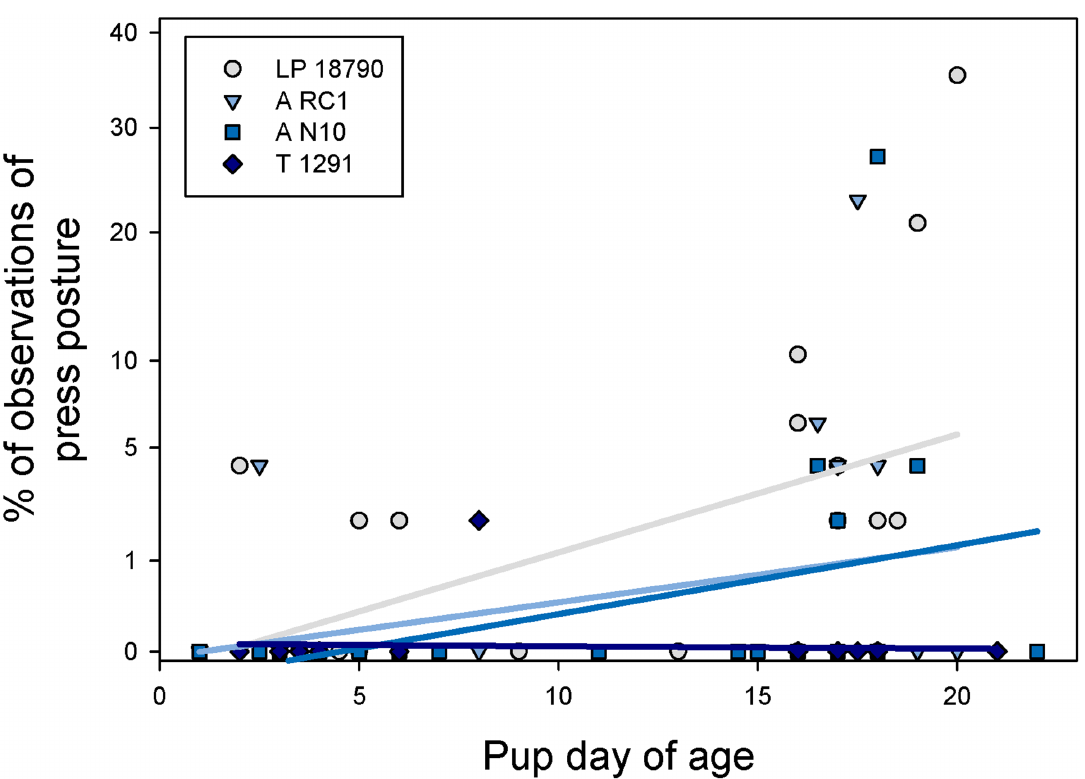
Fig 5. Proportion of press posture observed at different pup ages in the four cage sizes. Data points are plotted with the least squares line.